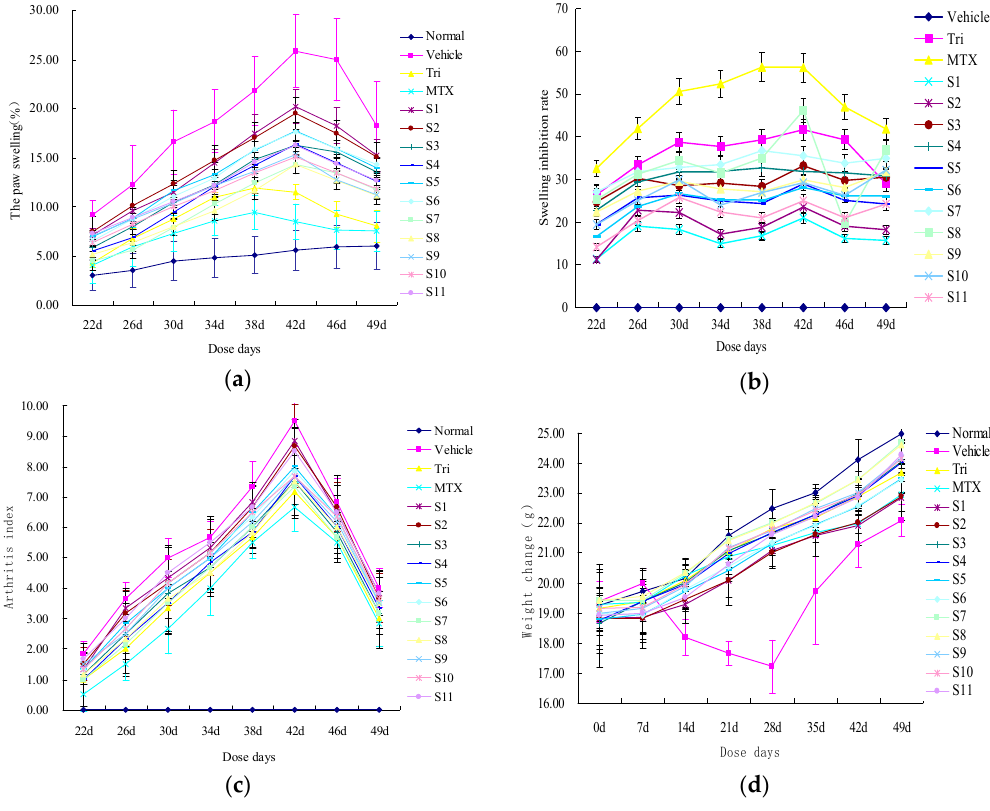
Figure 3. Anti-inflammatory activity index of ( a ) paw swelling (%); ( b ) swelling inhibition rate; ( c ) arthritis index (AI)’ and ( d ) body weight change.